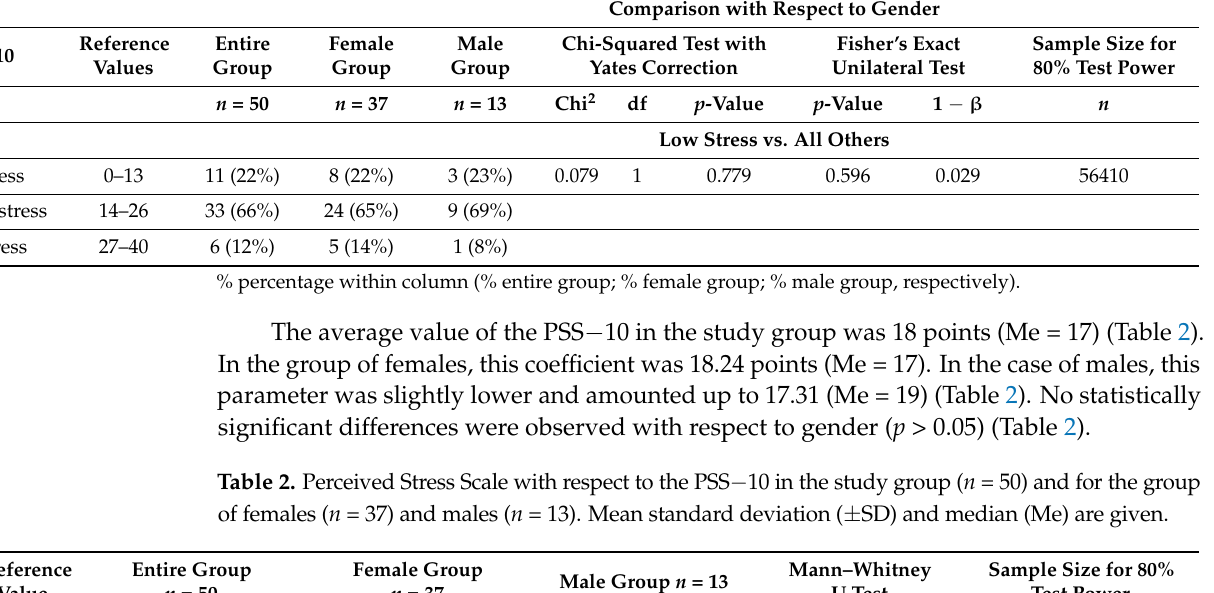
Table 1. Perceived Stress Scale with respect to the PSS − 10. Numerical and percentage values are given for the study group ( n = 50) and for the group of females ( n = 37) and males ( n = 13). Comparison with Respect to Gender Chi-Squared Test with Yates Correction